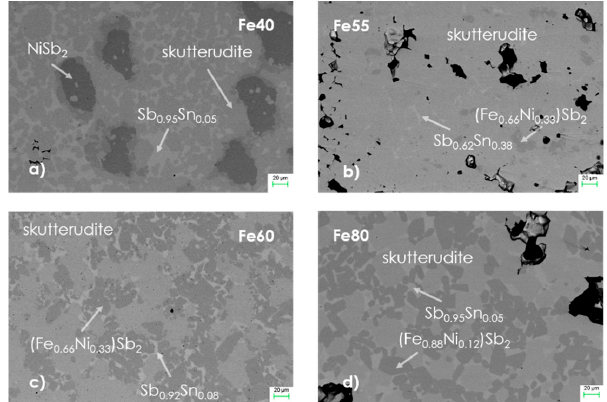
Figure 1. SEM microphotographs taken by backscattered electrons on the polished surface of the samples ( a ) Fe40, ( b ) Fe55, ( c ) Fe60, and ( d ) Fe80.